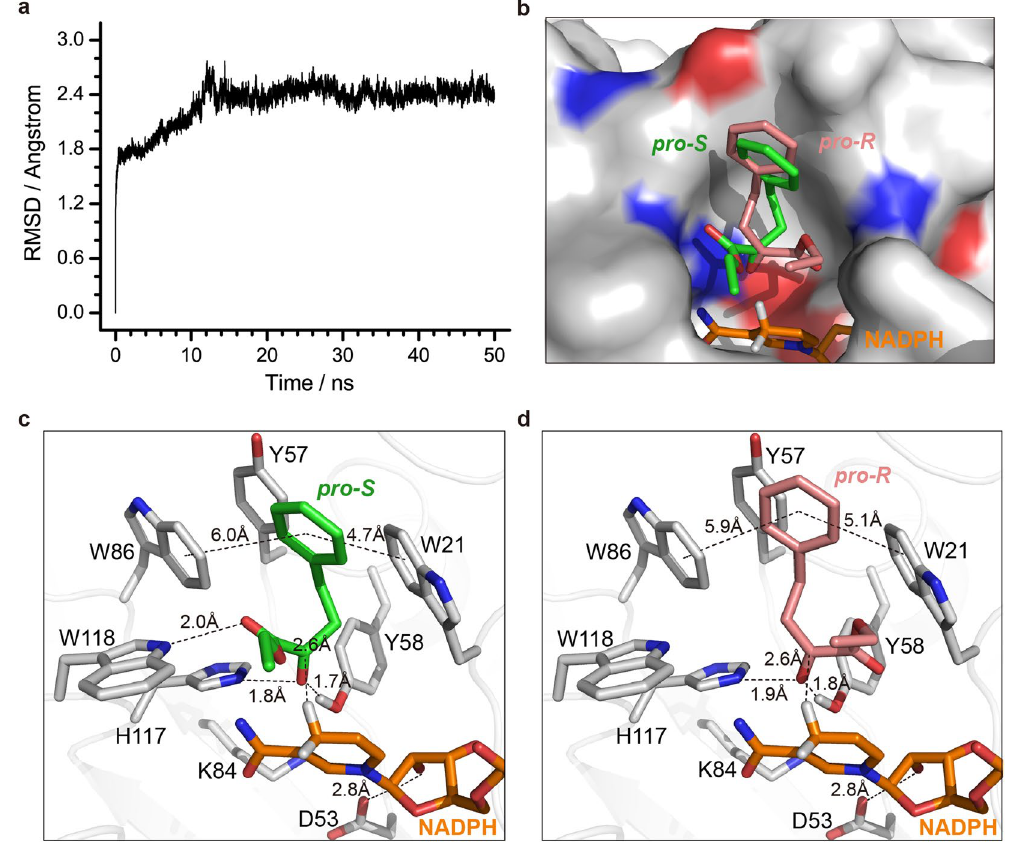
Figure 2. Molecular dynamic simulations of Tm1743 and docked conformations of Tm1743-NADPH-EOPB. ( a ) RMSD fluctuations of Tm1743 in the Tm1743-NADPH complex during the 50 ns MD simulation. ( b ) The pro - S (green) and pro - R (salmon) conformations of EOPB on the electrostatic surface of Tm1743. The positively charged, negatively charged and neutral amino acids are colored in blue, red, and gray, respectively. NADPH molecules are shown as orange sticks. ( c ) and ( d ) Stereo views of the pro - S (green) and pro - R (salmon) EOPB binding modes. Amino acids involved in EOPB coordination are shown as gray